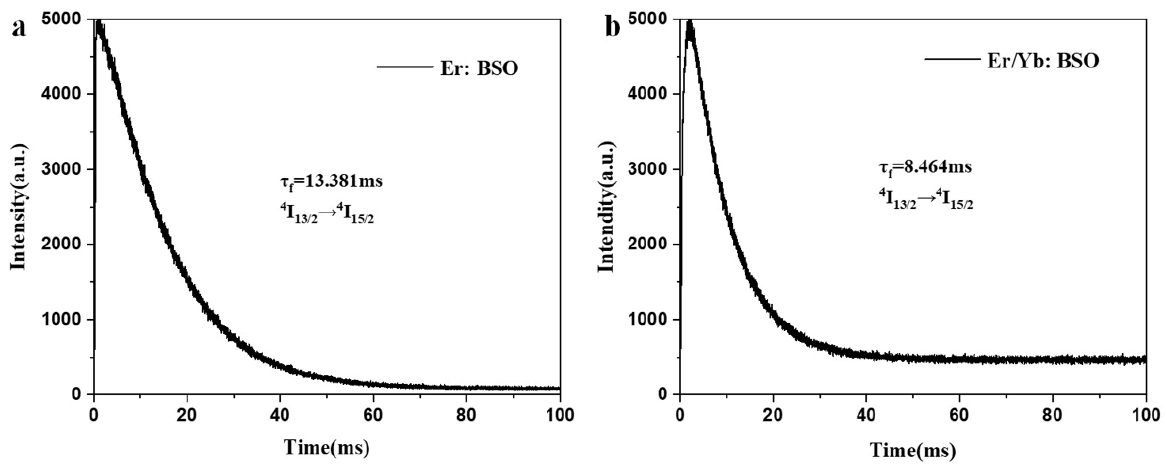
Figure 8. ( a ) Fluorescence decay curve of the Er: BSO excited by 976 nm radiation; ( b ) fluorescence decay curve of the Er/Yb: BSO excited by 976 nm radiation.